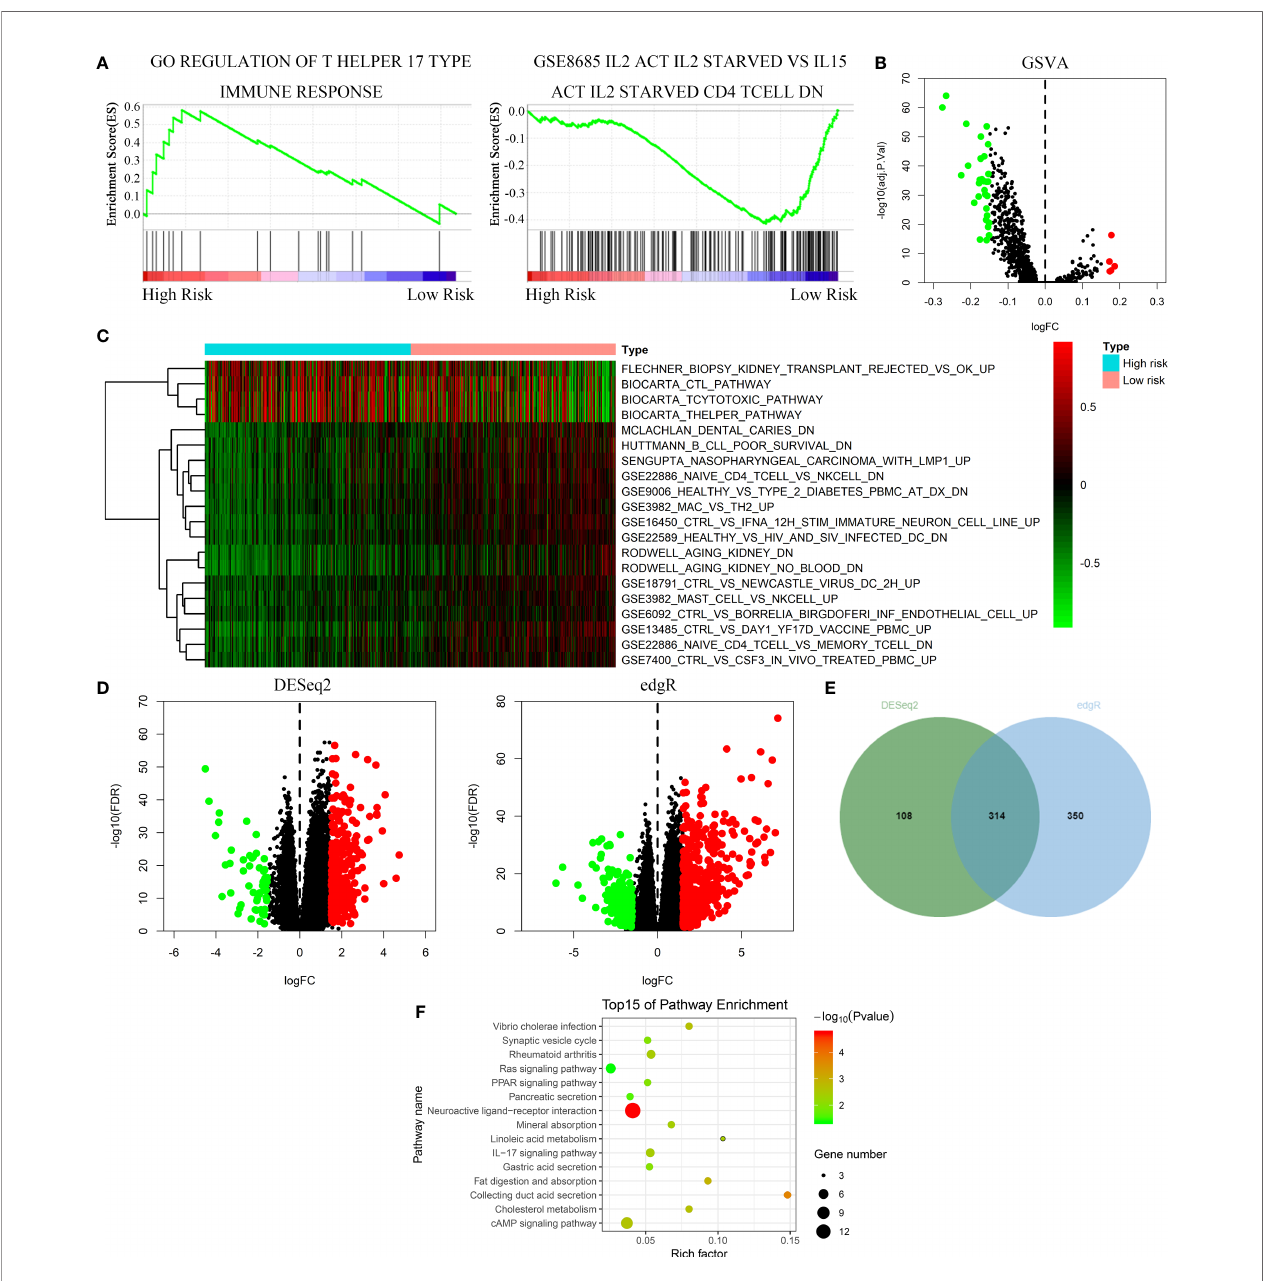
FIGURE 4 | The FeSig was obviously closely associated with immune-related pathways. (A – C) GSEA and GSVA showed that FeSig was correlated to immune cell related pathways. (D, E) A total of 314 DEGs were identi fi ed via DESeq2 and edgR package. (F) The DEGs were mainly enriched in immune-related